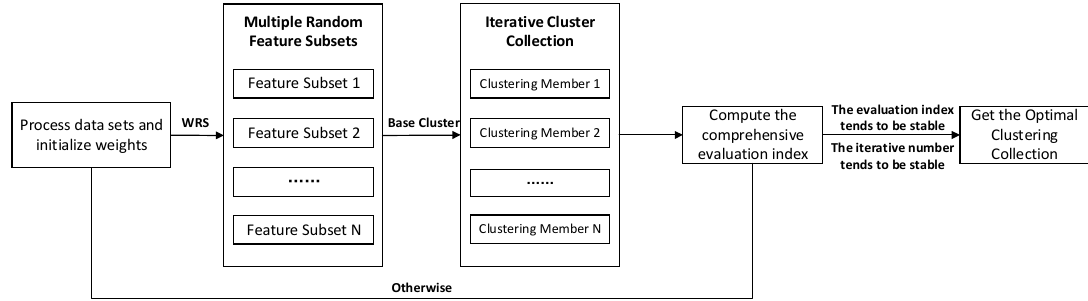
Figure 2. Iterative constructing clustering ensembles by weighted random sampling.